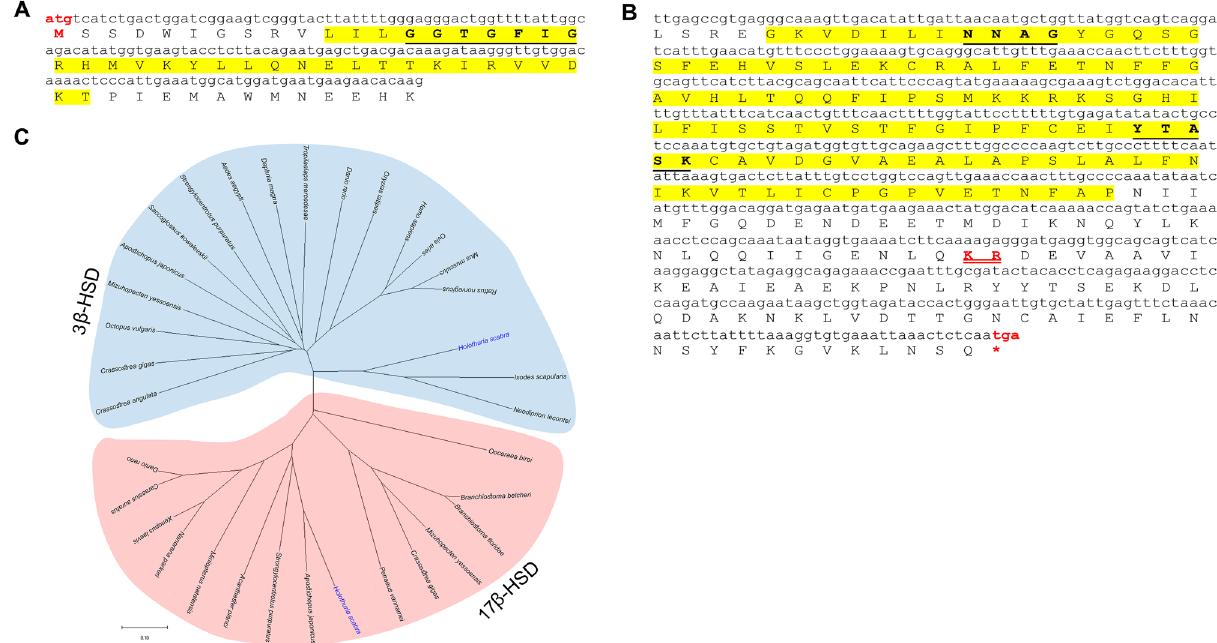
Figure 5. Characterization and phylogenetic tree analysis of H. scabra hydroxysteroid dehydrogenases (HSDs). ( A ) Hsc3β-HSD shows the start codons (red letters) and short-chain dehydrogenase/reductase (SDR) domain (yellow highlight) which contains NAD-binding motif (GGTGFIG) (bold underlined letters) ( A ). Shaded regions indicate motif sequences of amino acids identical to NAD-binding motif. ( B ) Hsc17β-HSD contains the short-chain dehydrogenase/reductase (SDR) domain (yellow highlight) that composed of 2 important motifs; NNAG and YxxxK (bold underlined letters), cleavage site (red double-underlined letters), and stop codons (red letters). ( C ) Phylogenetic tree of target HSDs involved in steroidogenesis constructed based on Neighbour- joining analysis with 1000 replicates bootstrap. Scale bar represents amino acid differences. Amino acid sequences and their accession number are shown in